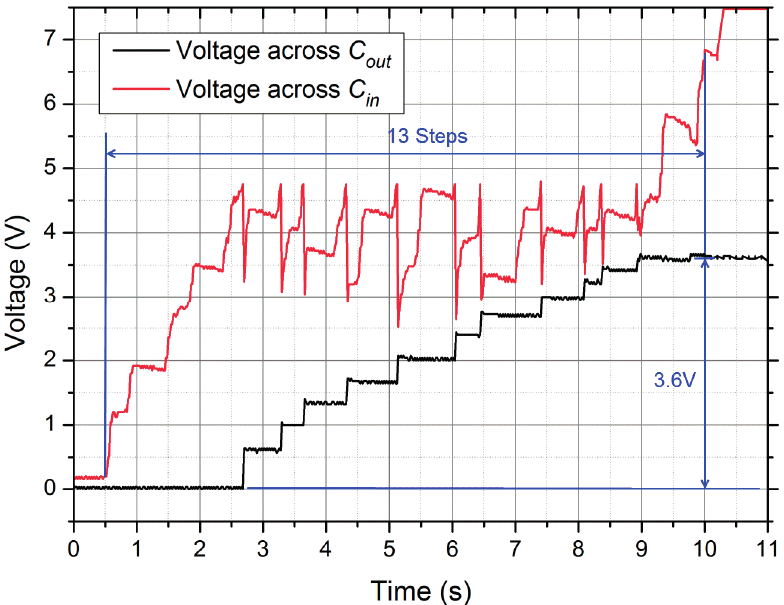
Figure 9. The two measured voltages across C voltage reached the set value 3.6 V.